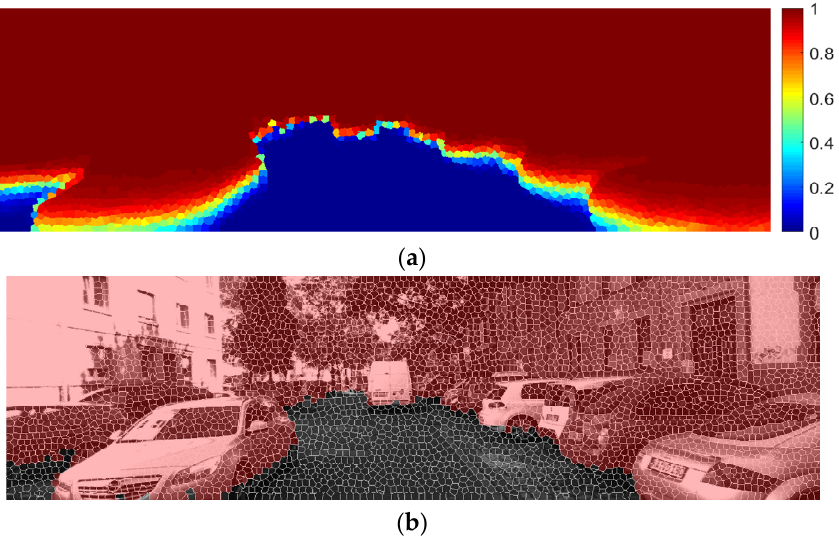
PR and classification result of OD-SPH method: ( a ) Figure 8. The probabilistic distribution of Figure 8. The probabilistic distribution of PR SPH and classification result of OD-SPH method: SPH ( a ) PR SPH probability distribution; ( b ) OD-SPH method classification PR probability distribution; ( b ) OD-SPH method classification result. SPH